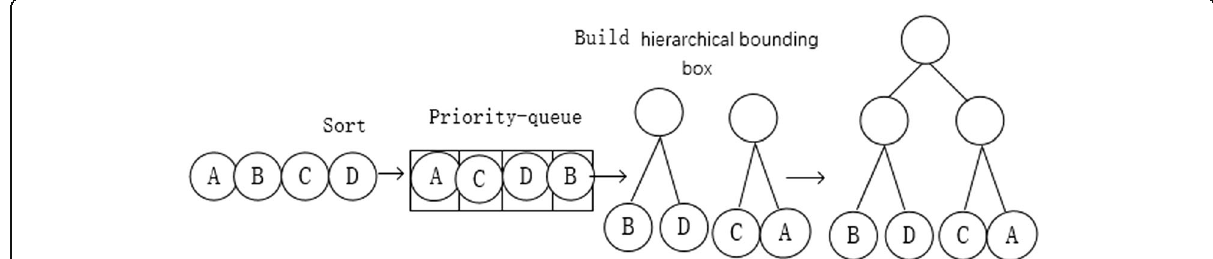
Fig. 4 The construction of hierarchical bounding box tree (take binary tree as example, the circle in the figure stands for primitive that make up the collider)